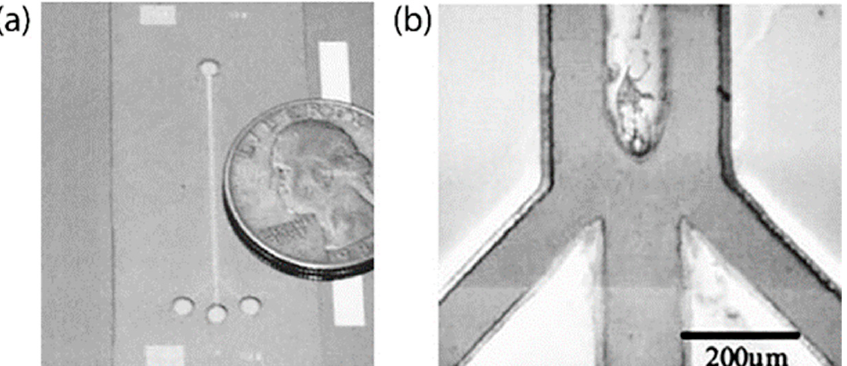
Figure 1. Initial implementation of magnetophoretic separator in a microfluidic platform. ( a ) Top view of the device. ( b ) Microscopic view. Reprinted from [44] with the permission of AIP Publishing, copyright 2004.